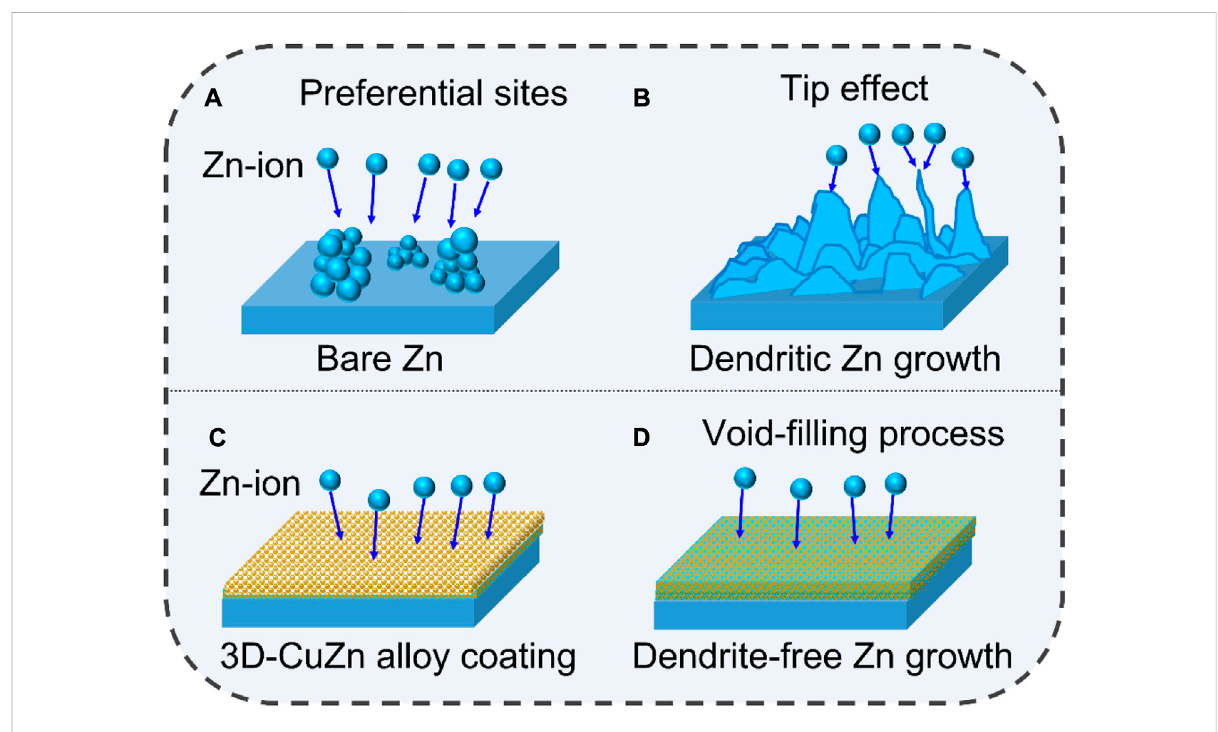
FIGURE 4 Zn growth schematics of bare Zn and 3D-Cu-coated electrodes. (A,B) Bare Zn electrode. (C,D) 3D-Cu-coated